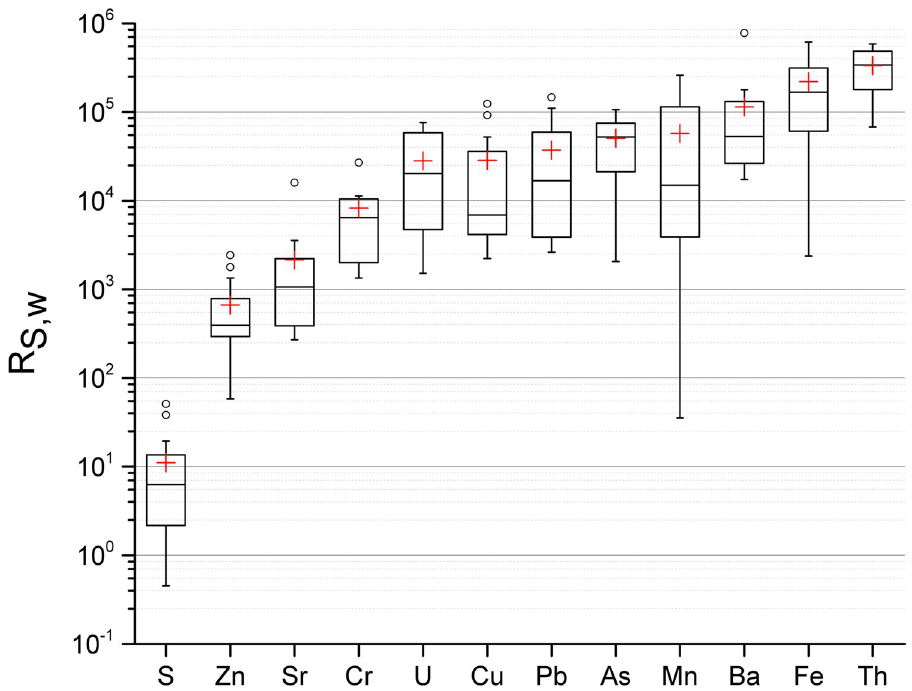
Fig 7. The ratio between element concentration in surface sediment and surface water, R S,W , from 19 pit lakes. The height of the box shows the interquartile range, which contains 50% of the values, the horizontal line inside the box shows the median value and the red cross denotes the mean value. The whiskers are lines that extend from the box to the highest and lowest values excluding outliers (o). Outliers represents those values being 1.5 larger than the length of the box from its upper or lower border. Data also given in supplementary data